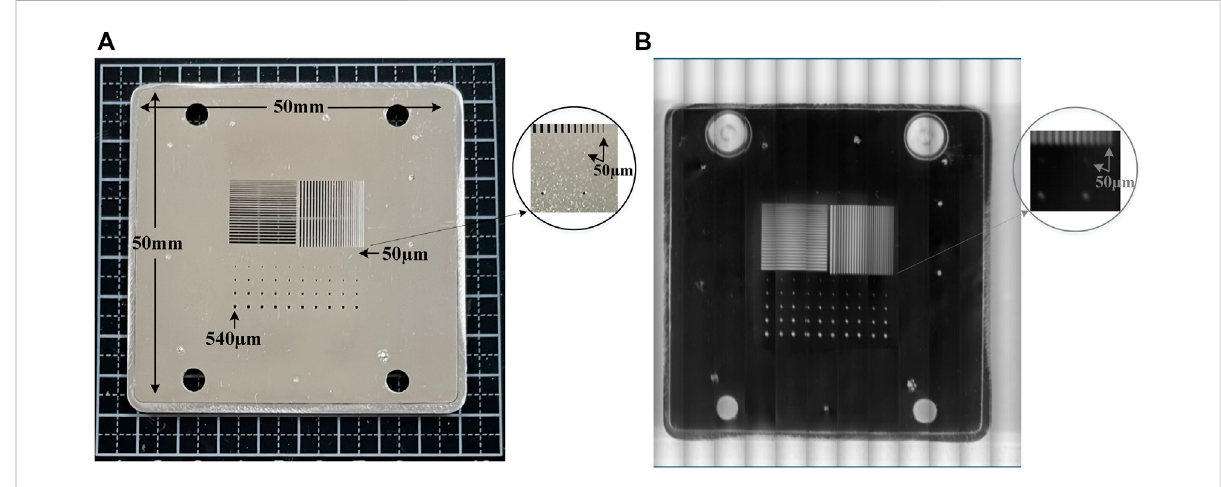
FIGURE 7 (A) Metal resolution plate. (B) The gray scale imaging result of